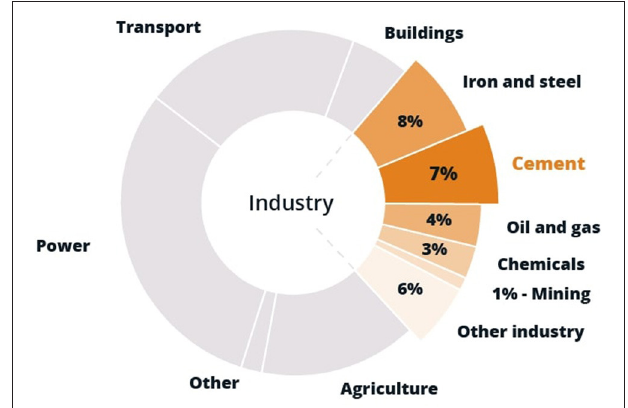
FIGURE 1 | Cement production’s share of global CO 2 emissions (adapted from Czigler et al., 2020).